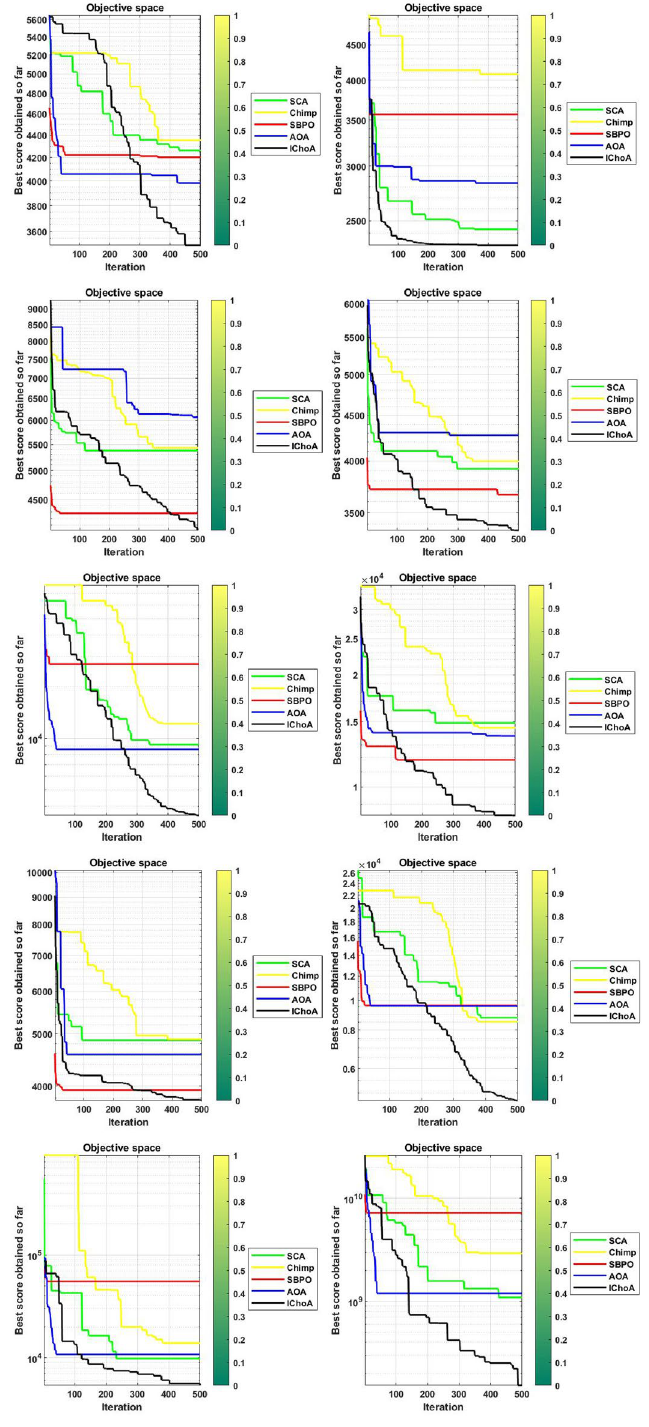
Figure 6. Convergence graphs of evolutionary algorithms on composition test